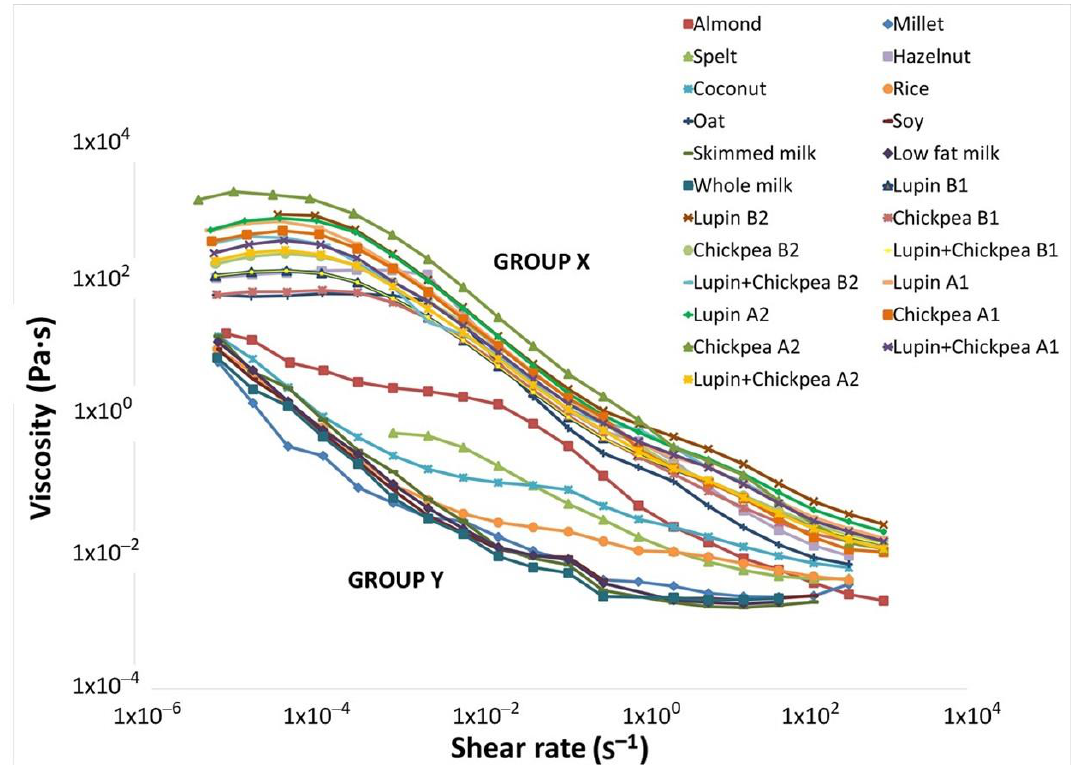
Figure 4. Flow curves showing the shear viscosity evolution for the pulse-based beverages